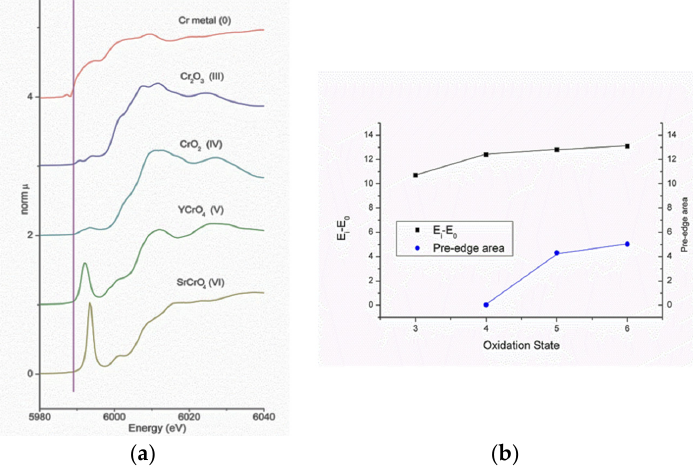
Figure 14. ( a ) XANES spectra of Cr compounds of increasing Cr oxidation states. The vertical line is the position of the first inflection ( E 0 ) in the edge on Cr metal spectrum. Spectra are vertically shifted for clarity; ( b ) Oxidation state dependence of the main absorption edge position (first inflection— E i ) and pre ‐ edge peak area from the spectra presented at (a) [100].